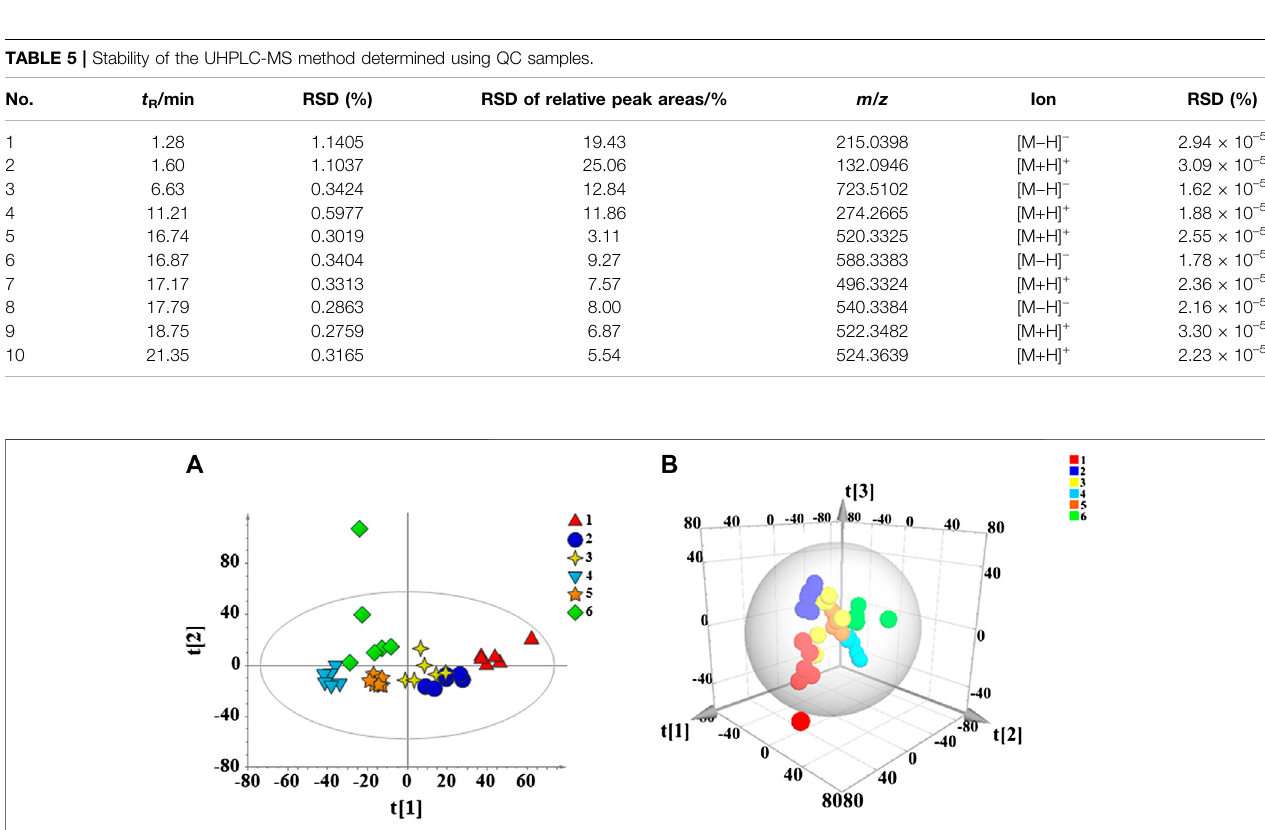
FIGURE 7 | PCA score plots of all mouse serum samples. 2D diagram (A) and 3D diagram (B) . 1: Model group, 2: Control group, 3: APS, 4: APS-I, 5: APS-II, 6: APS-III.